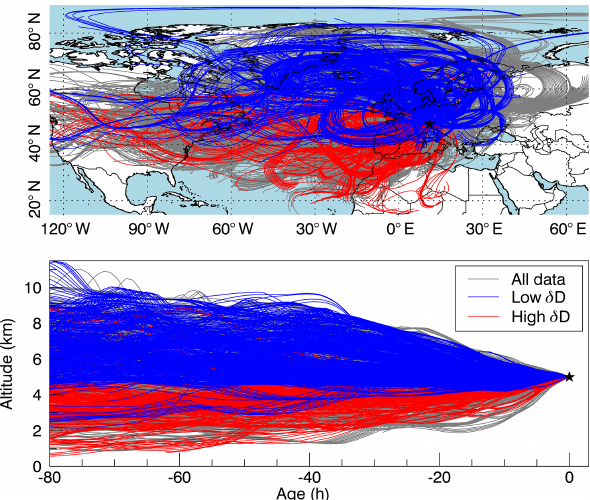
Figure 4. Backward trajectories of air masses arriving above Zugspitze (marked as black star) at 5kma.s.l. altitude: map pro- jection (upper panel) and vertical cross section (lower panel) of tra- jectories for all FTIR measurement times in 2005–2015 (grey lines) and for days identified as δ D col outliers (blue and red lines).